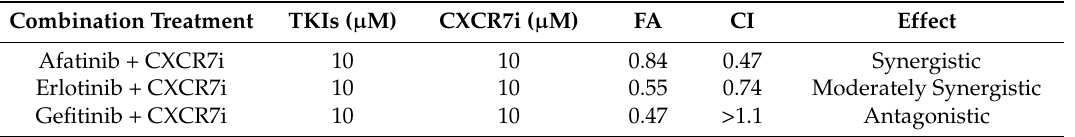
Table 1. Effect of concomitant combination of EGFR-TKI (TKI: tyrosine kinase inhibitor) and CXCR7 inhibitor on A549 cells based on the Chou and Talalay method.